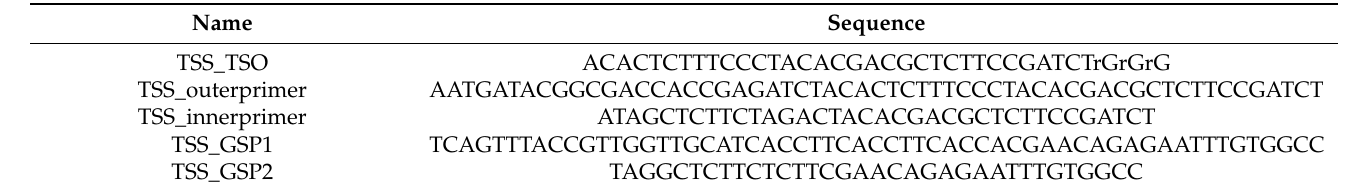
Table 3. Primers used to determine the transcription start site of phage promoters with 5 (cid:48) -